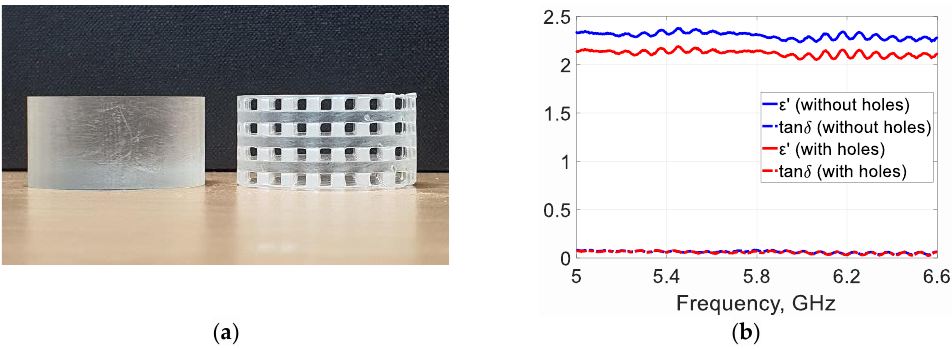
Figure 5. Dielectric properties of the printed resin. ( a ) Printed reference and perforated cylinders with resin material. ( b ) Measured dielectric properties of the samples.